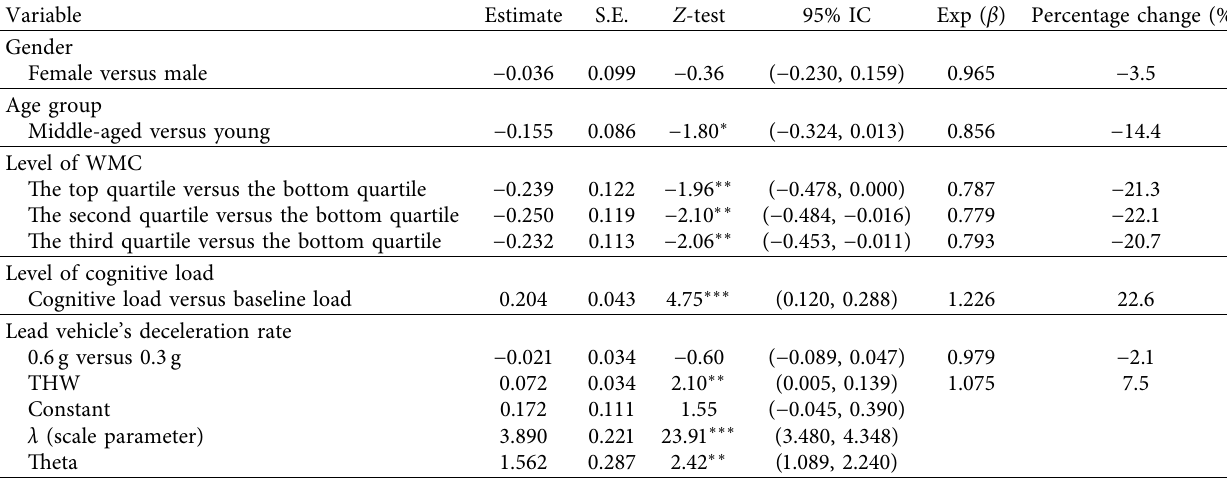
Table 3: Parameter estimates of Weibull AFT models with heterogeneity.